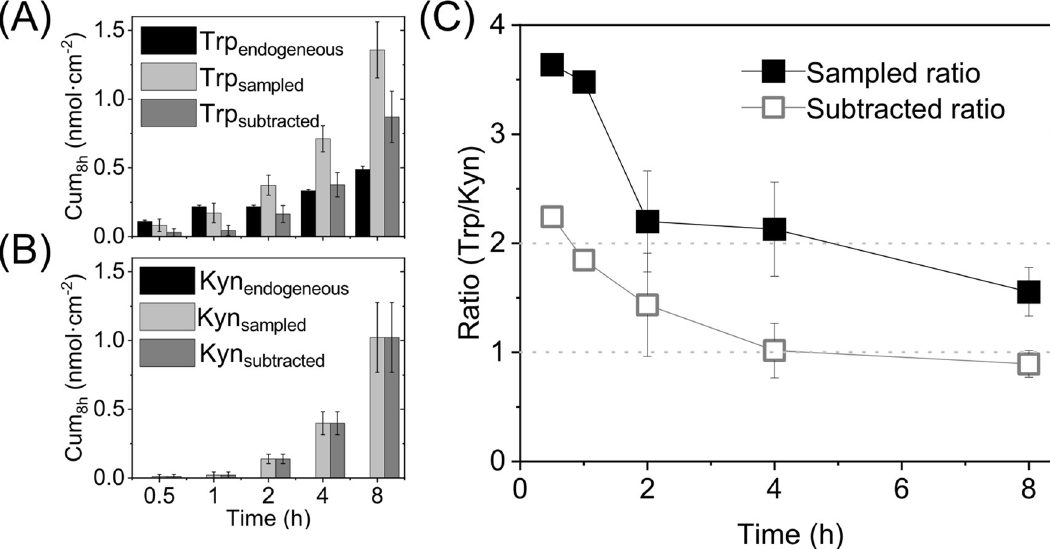
Figure 3. The influence of endogenous Trp on the Trp/Kyn ratio. Amounts of ( A ) Trp and ( B ) Kyn corresponding to the endogenous, sampled, and subtracted (= sampled − endogenous) quantities ( n = 6, except for Trp endogenous where n = 3). ( C ) Sampled and subtracted Trp/Kyn ratio based on the data in ( A ) and ( B ); n = 6 for the sampled ratio and n = 1 (30 min and 1 h); n = 3 (2 h); n = 6 (4 h); n = 6 (8 h) for the subtracted